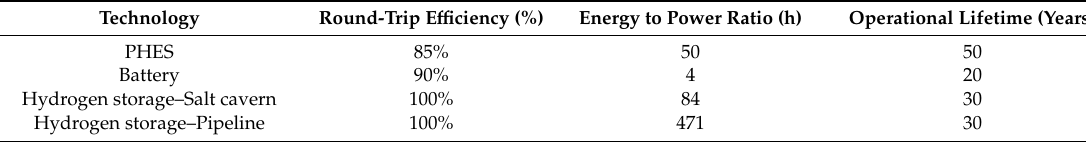
Table A8. Technical parameters of storage systems. Data based on References [38–40,92].